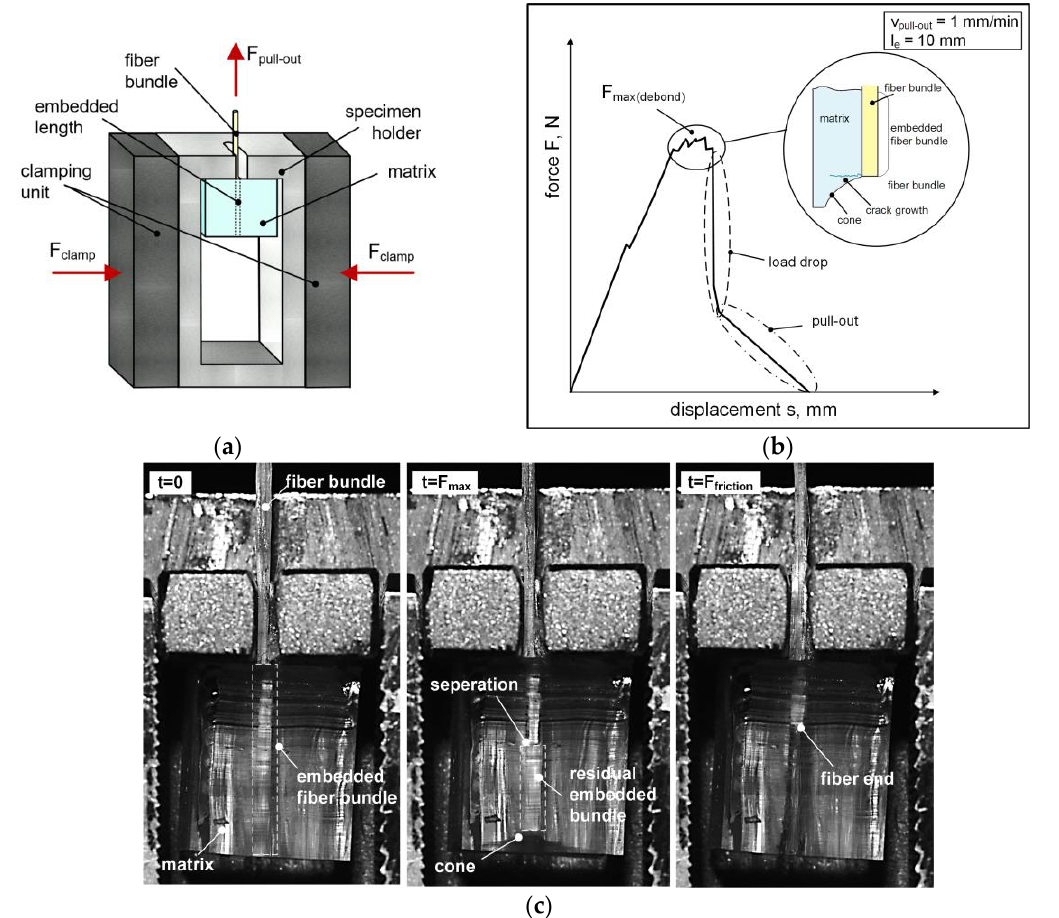
Figure 2. Schematic illustration of the test procedure considering the modified specimen holder ( a ), typical force–displacement graph including the principal performance steps ( b ) and timeline of an FBPO test representing the separation procedure ( c ).